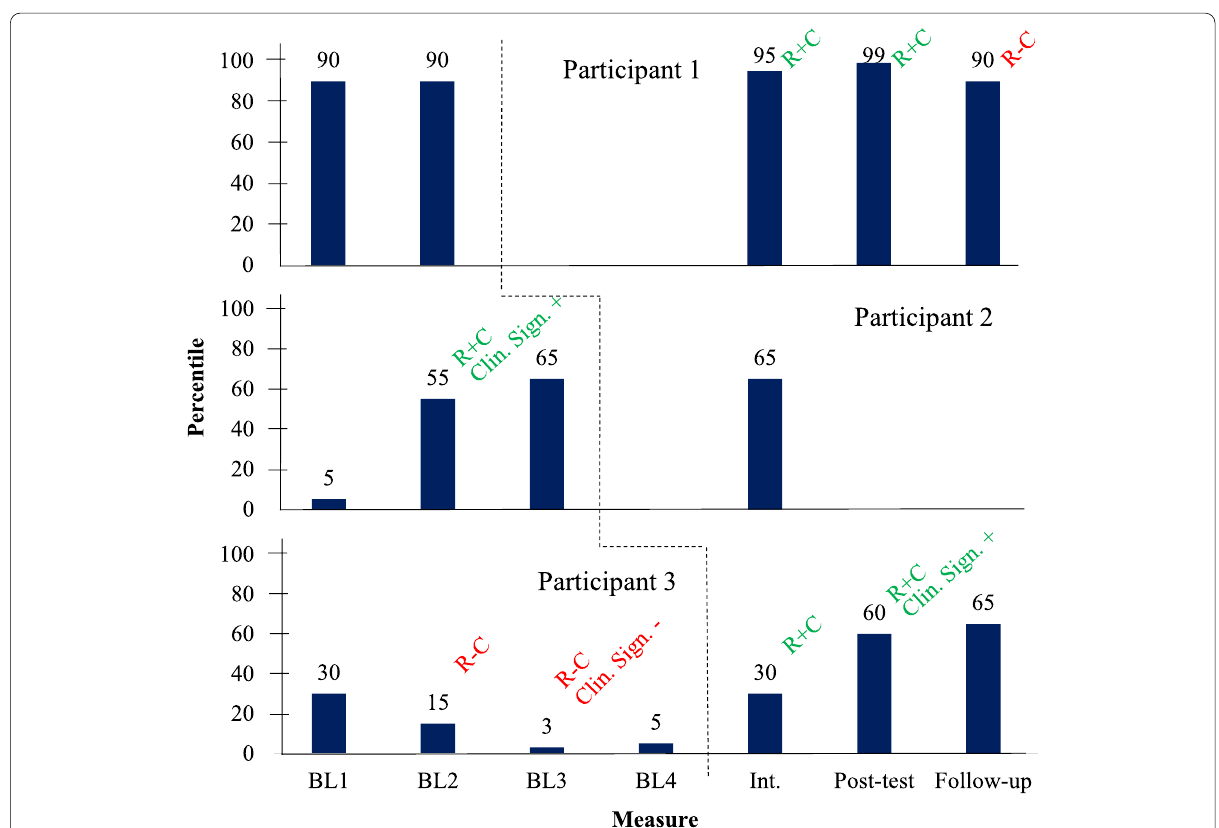
Fig. 2 Social skills total scores percentiles (IHS‑2 Del Prette). Note : BL Clin. Sign. clinically significant positive change; Clin. Sign. ‑ + = intervention for each